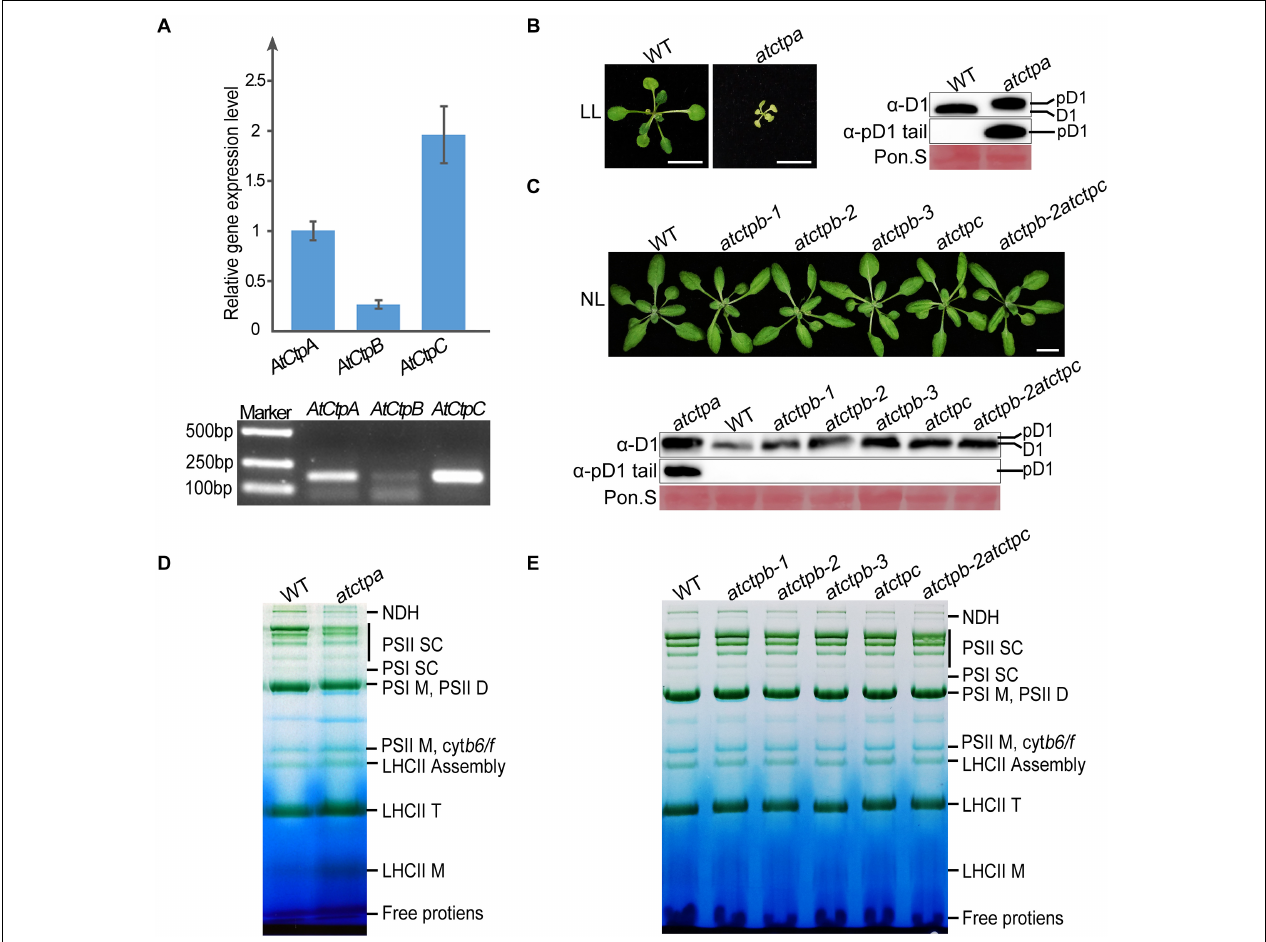
FIGURE 2 | Characterizations of atctpa , atctpb, and atctpc mutants. (A) AtCtp transcript levels in 3-weeks-old wild-type (WT) rosette leaves. Upper panel shows quantitative RT-PCR results; lower panel shows semi quantitative qRT-PCR analysis. For qRT-PCR, GAPDH ( AT3G26650 ) was used as internal control for primary data normalization. Error bars indicate standard deviations (SD) from three biological replicates. (B) Characterization of atctpa mutant. WT and atctpa were grown on 1/2 MS with 1% sucrose under continuous low light (LL, 25 µ mol/s/m 2 ) for 3 weeks (Left). Scale bars represent 1 cm. The D1 processing status was analyzed by immunoblotting with α -pD1 tail (for pD1) and α -D1 (for D1 and pD1) antibodies (Right). The filters stained with Ponceau S (Pon. S) were used as loading controls. (C) Characterizations of atctpb and atctpc mutants. WT, single mutants ( atctpb -1, -2, -3, and atctpc ), and double mutant ( atctpb -2 atctpc ) were grown in soil under continuous normal light (NL, 80 µ mol/s/m 2 ) for 3 weeks (Upper). Scale bars denote 1 cm. The D1 processing statuses were analyzed by immunoblot against α -pD1 tail (for pD1) and α -D1 (for D1 and pD1) antibodies (Lower). The pD1 protein from atctpa mutant in panel (B) were used as positive control. The filters stained with Ponceau S (Pon. S) were used as loading controls. (D,E) BN-PAGE analyses of atctpa , atctpb , and atctpc mutants. The plants in panel (D) were grown on 1/2 MS under continuous LL light for 3 weeks. The plants in panel (E) were grown in soil under continuous NL light for 3 weeks. Thylakoid membrane protein complexes (12 µ g chlorophyll) were loaded on BN-PAGE gels for